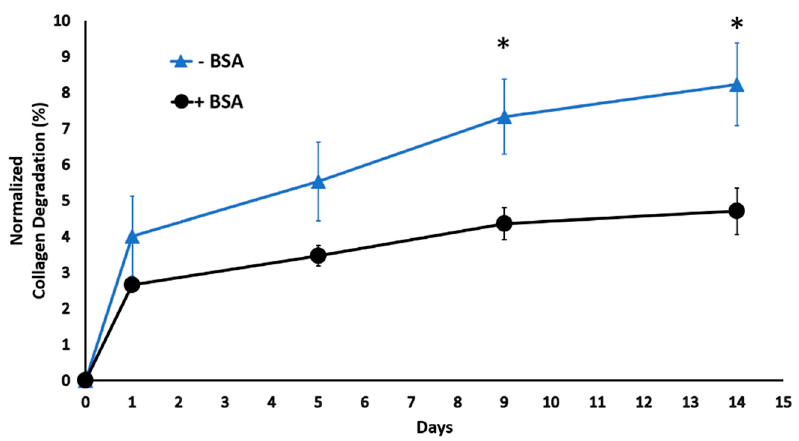
Figure 1. The kinetic degradation of the scaffold with and without BSA under a digestive inflam ‐ matory environment. * p <